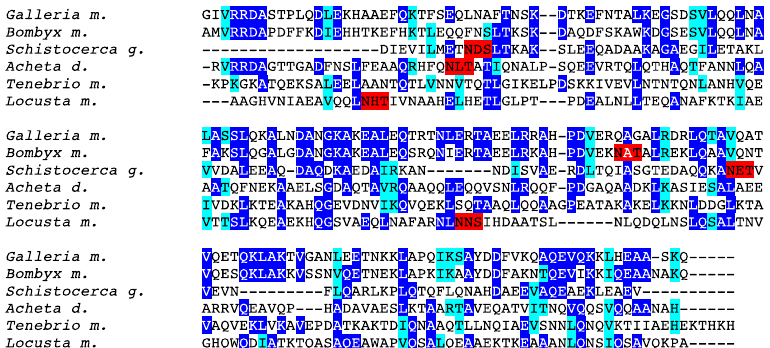
Figure 7. Superposition of the ribbon diagrams of hexamerin from Apis mellifera (red), Galleria mellonella (blue), Locusta migratoria (green), and Tenebrio molitor (purple). As previously reported, other less specific potential allergens such as apolipophorin III and larval cuticle protein, exhibit rather well conserved amino acid sequences but share a highly conserved three-dimensional structure. As an example, the multiple alignment of amino acid sequences of apolipophorin III from different edible insects shows a moderate degree of identity and similarity (Figure 8), even though their three-dimensional structures are nicely superposed (Figure 9).